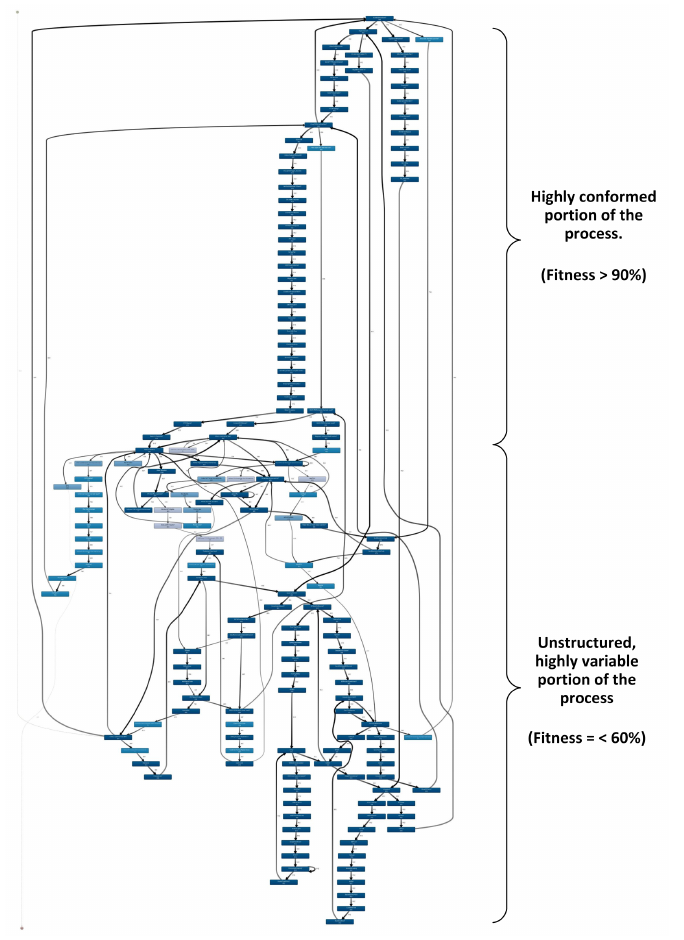
Figure 3. Heuristic miner model for customer diagnostic process.